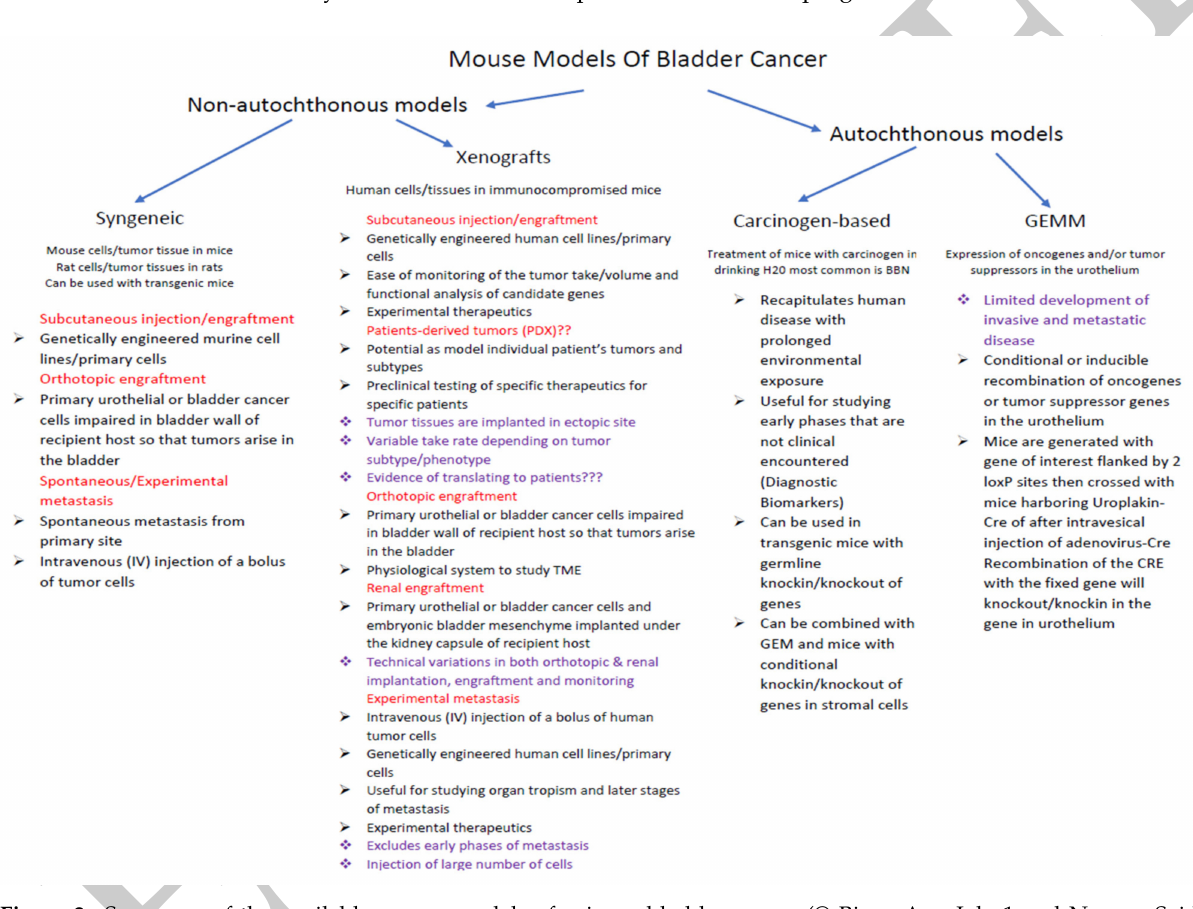
Figure 2. Summary of the available mouse models of urinary bladder cancer (© Bincy Anu John1 and Neveen Said, Insights from animal models of bladder cancer: recent advances, challenges, and opportunities, Oncotarget, 2017, Vol. 8, (No. 34)